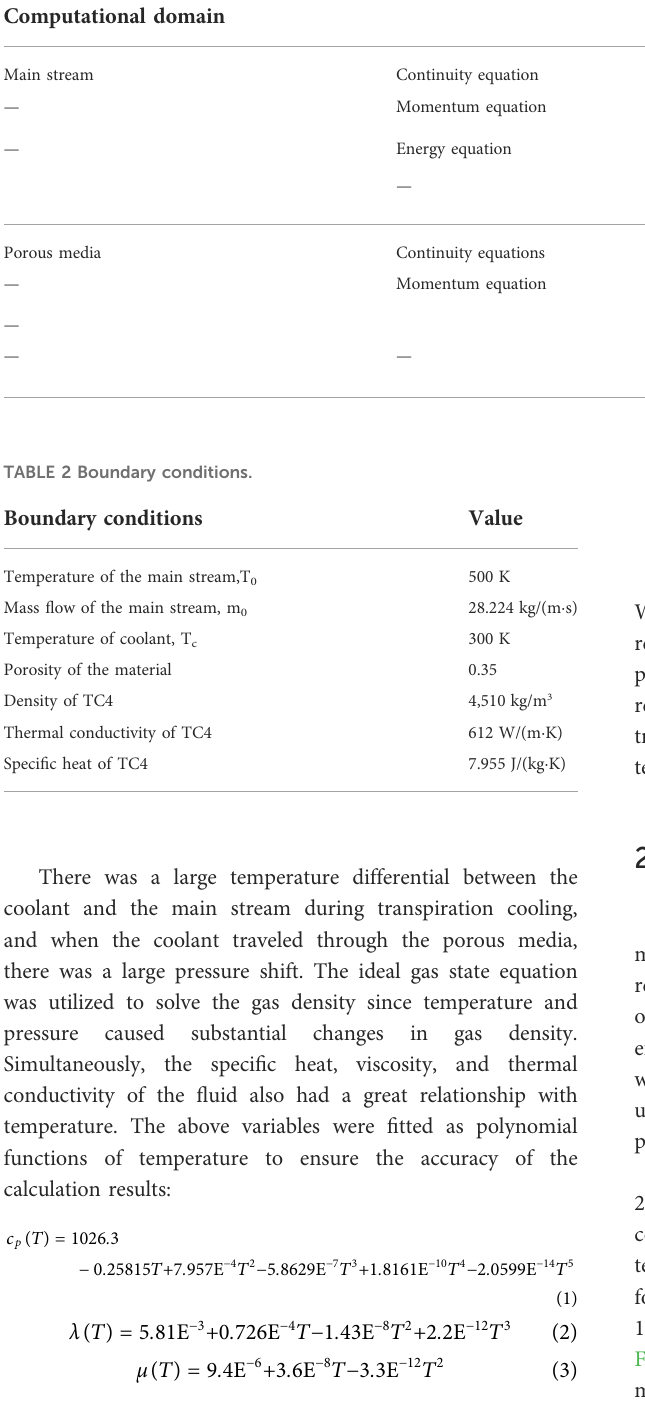
Figure 4. In the diagram, x/L represents the relative position of monitoring points on the outer surface of the porous plate. It showed that Mesh 2, Mesh 3, and Mesh 4 exhibited a high degree of coincidence, with a maximum divergence of 0.5%, Mesh 1 had a temperature distribution that was considerably different from the other three. Considering the accuracy and ef fi ciency of calculation, model with 137,793 grid was selected for numerical simulation calculation.